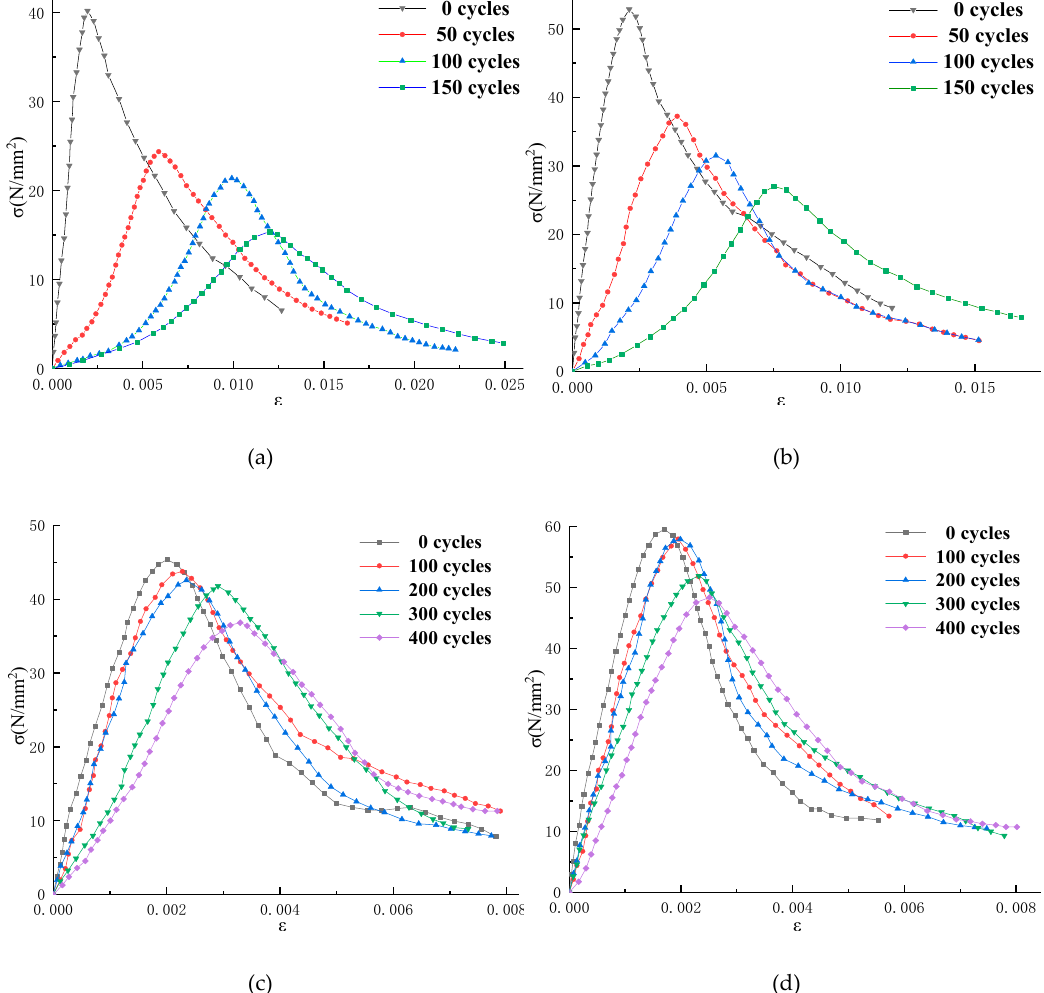
Figure 4. Stress–strain curve of concrete specimens under uniaxial compression after freeze–thaw cycles: ( a ) O-C40 concrete; ( b ) O-C50 concrete; ( c ) AE-C40 concrete; and ( d ) AE-C50 concrete.